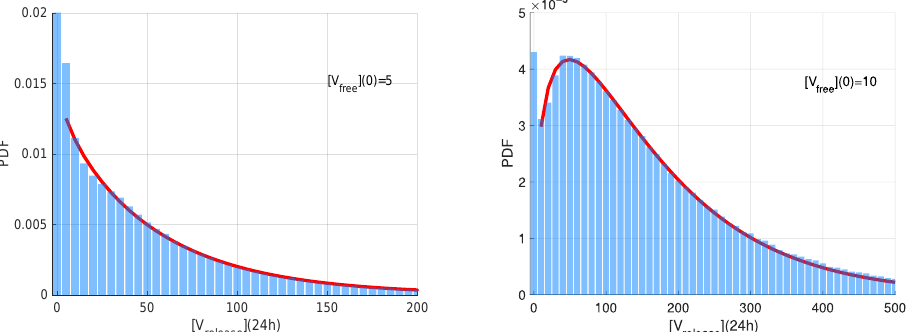
Figure 3. Normalised histograms for the released virions number for [ V free ]( 0 ) = 5 ( left ) and [ V ]( 0 ) = 10 ( right ). The red line shows the approximation of the histogram by the Gamma free distribution fitted to the histogram by the least squares method.